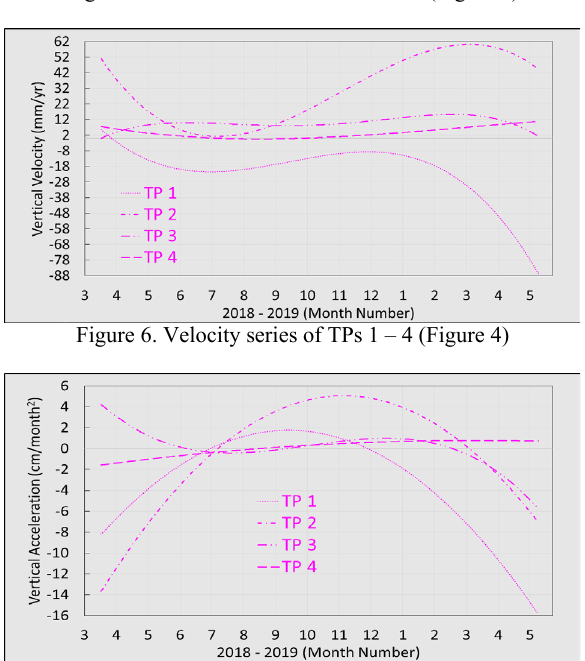
Figure 5. Movement series of TPs 1 – 4 (Figure 4)